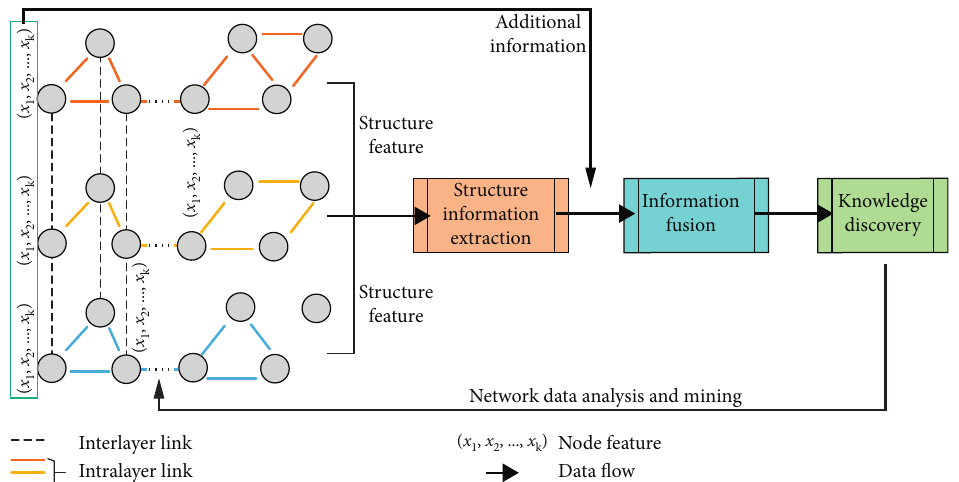
Figure 1: A network fusion architecture of undirected multiplex networks. On the left side of the figure, this undirected multiplex network has three layers, representing three types of relations, respectively. Each layer contains seven entities. Entities with the same name in different layers represent the same node. On the right side, three critical components of multiplex network fusion are